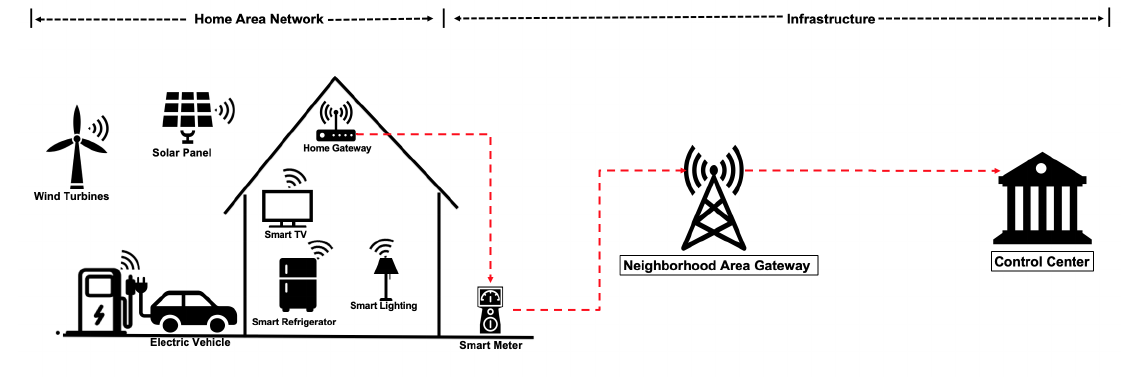
Figure 1. System architecture of SG-HANs.